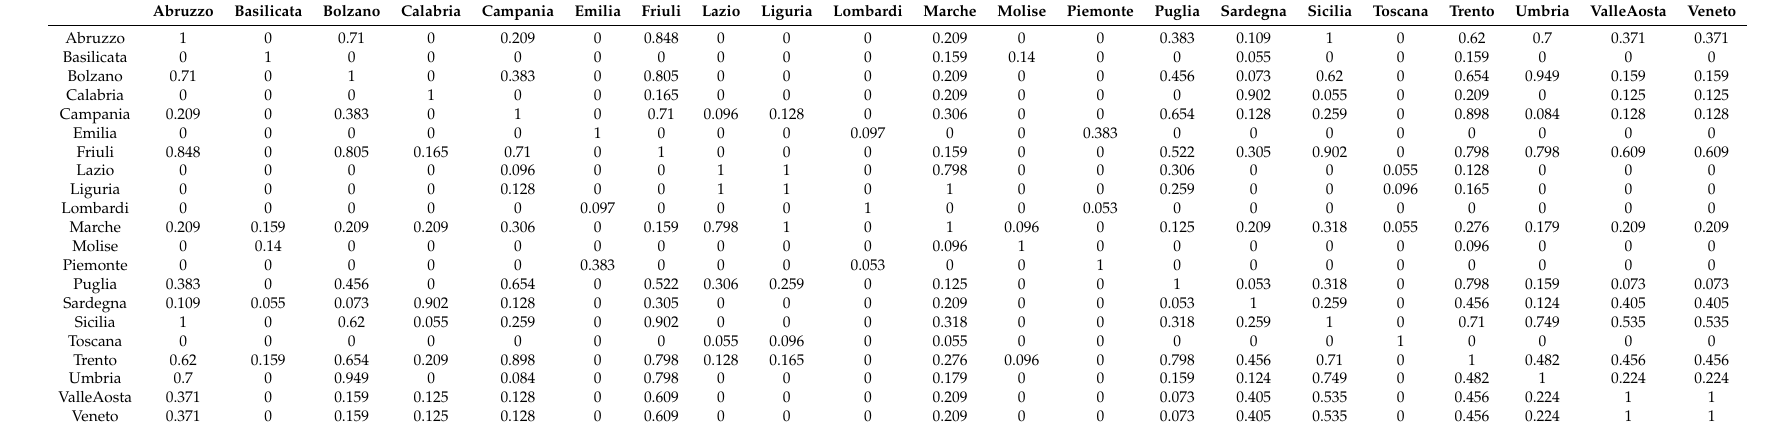
Table A35. Similarity values of New Currently Positive network in the fourth week.